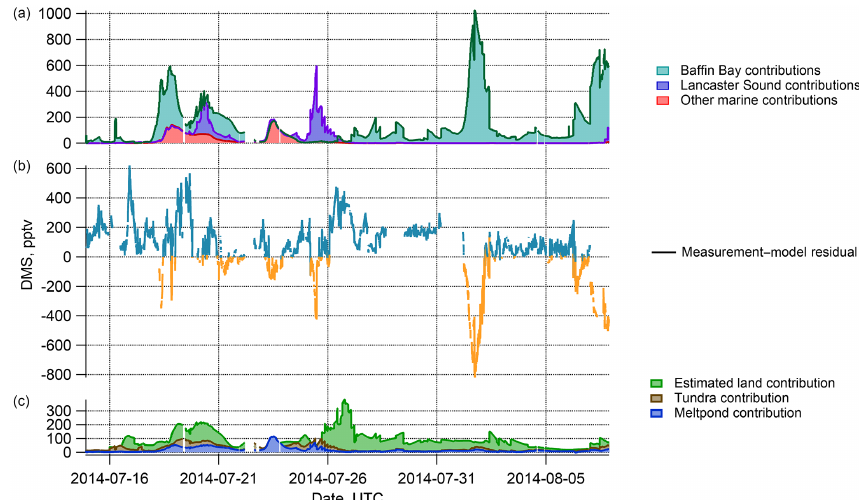
Figure 4. (a) GEOS-Chem (GC) simulated atmospheric surface-layer DMS mixing ratio along Amundsen ship track as in Fig. 3a, with indi- cation of contributions from Baffin Bay (blue), from Lancaster Sound (purple), and from other marine regions (red). (b) Difference between measurement and simulated DMS mixing ratio time series along the ship track showing model overprediction in blue and underprediction in orange. (c) GC simulated DMS contributions along ship track from sensitivity tests for additional DMS sources such as melt ponds (blue), tundra (brown), and unknown sources possibly including forests, soils, or lakes in proximity to biomass burning